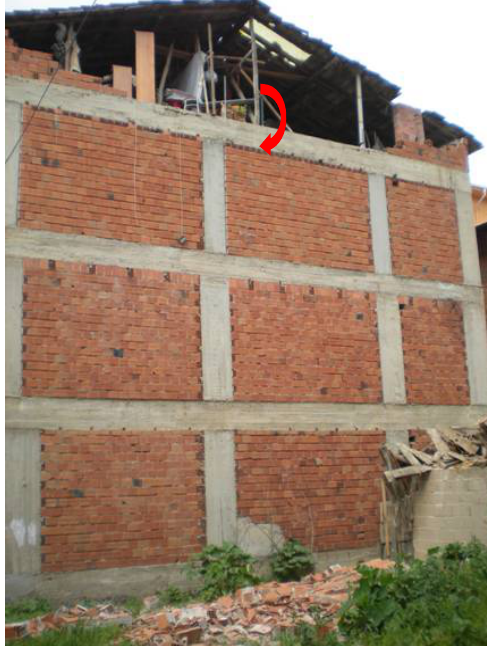
Figure 11. Unconfined gable wall damage.